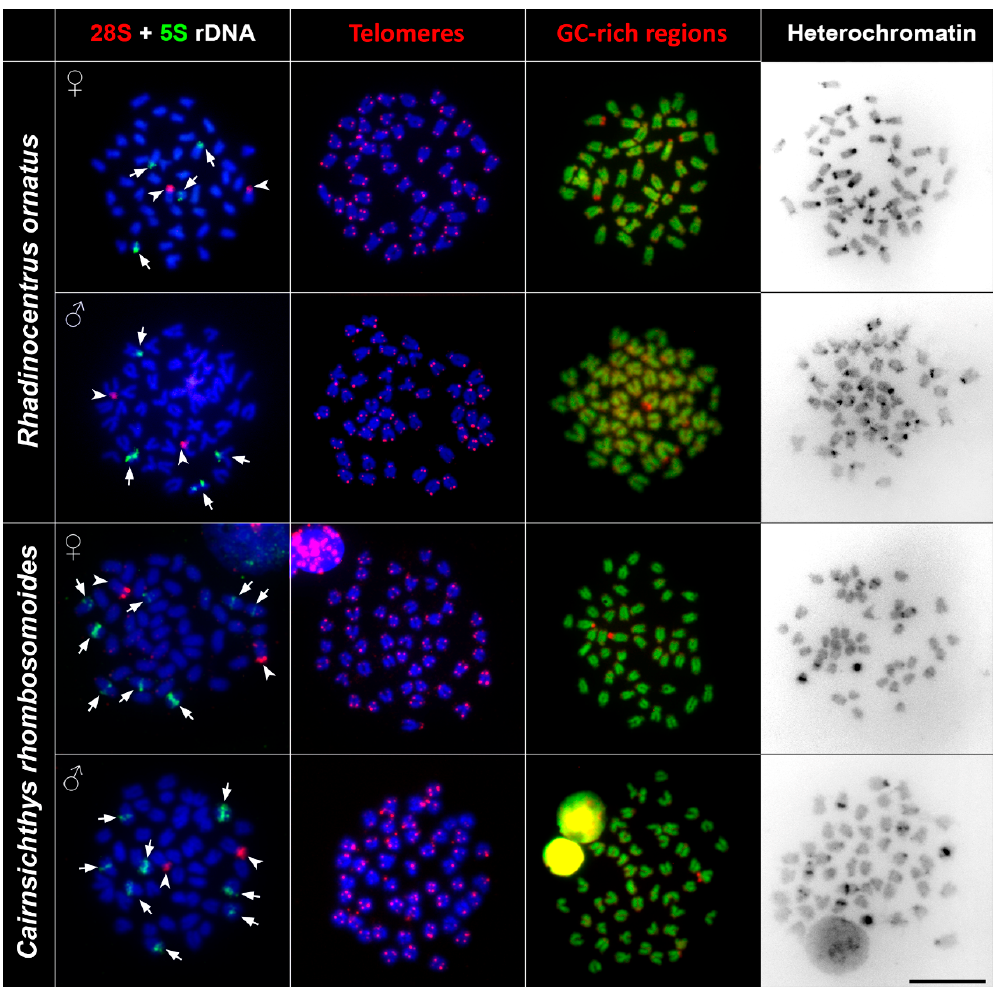
Figure 3. Comparative chromosome analyses of R. ornatus and C. rhombosomoides . First column: DAPI-stained metaphases (blue), 28S rDNA (red, indicated by arrowheads), 5S rDNA (green, indicated by arrows) hybridisation signals; second column: DAPI-stained metaphases (blue), telomere repeat hybridisation signals (red); third column: DAPI-stained metaphases (green), signals of GC-rich regions (red); fourth column: inverted DAPI-stained C banding pattern. Bar = 10 μ m.